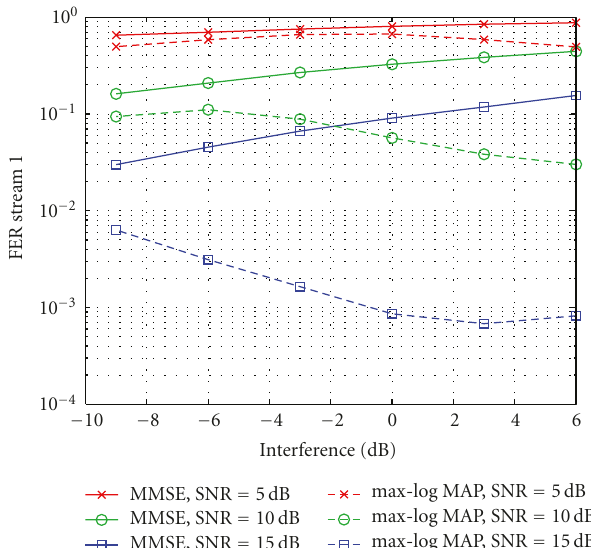
Figure 8: Frame error rate of the first stream of the of the MMSE and max-log MAP receiver for a frequency flat Rayleigh fading channel with perfect CSIR. Results are plotted for di ff erent SNR levels of the first stream. The x -axis denotes the interference of the second stream w.r.t. the first stream.